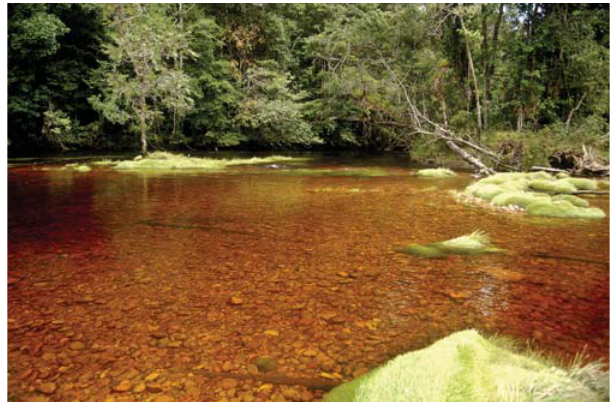
Fig. 5. Neblinichthys habitat in the Waruma River 05º28’32”N